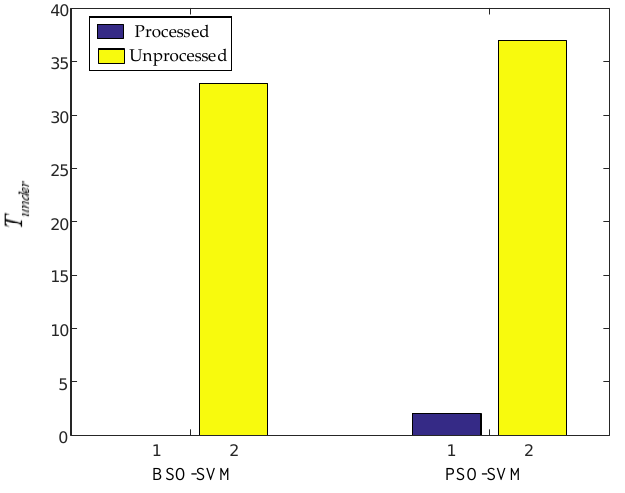
Figure 4. Comparison of the results T under .